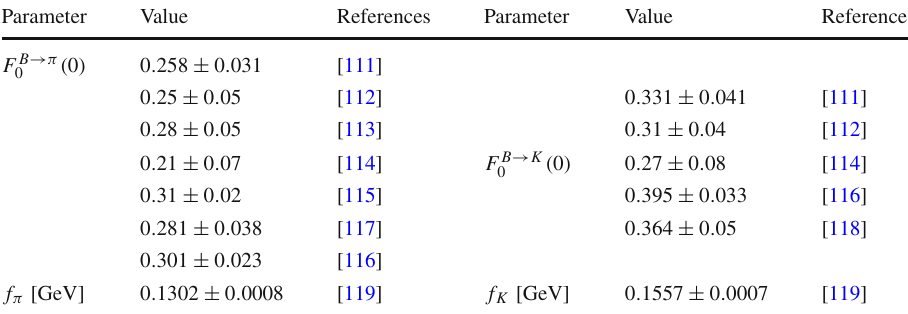
Table 3 Form factors for the transitions B → π and B → K and decay constants f π and f